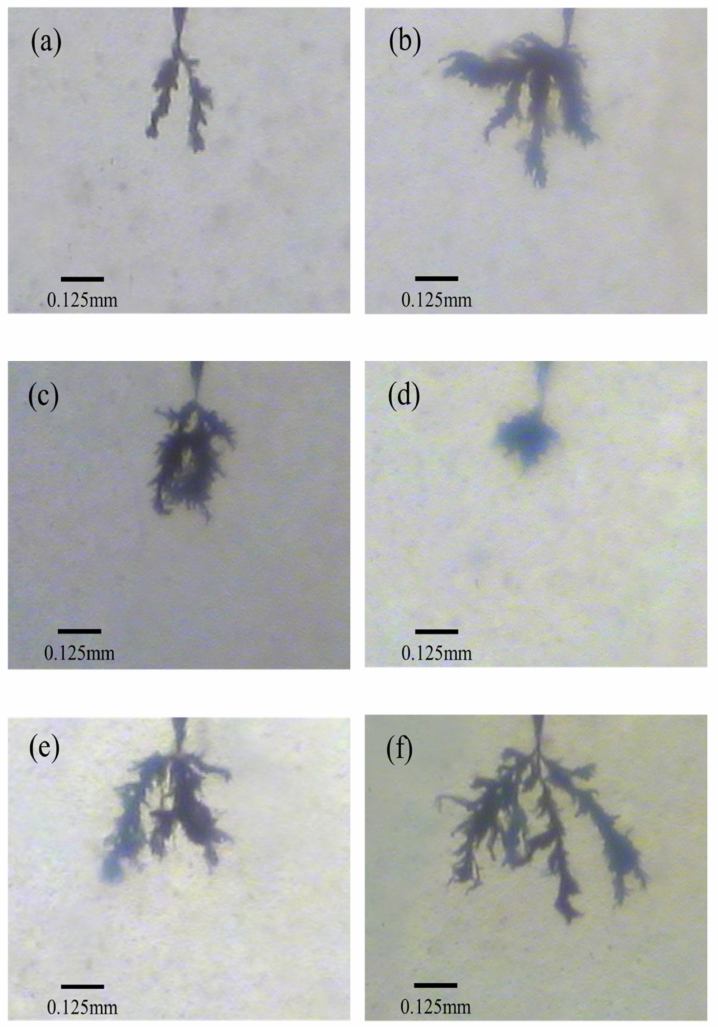
Figure 9. The electrical tree microscopic morphology of PP and Ac-SEBS/PP with different degrees of acetylation when the voltage is applied for 7200 s ( a ): PP, ( b ): PP/SEBS; ( c ): 2%; ( d ): 4.6%; ( e ): 6%; ( f ):